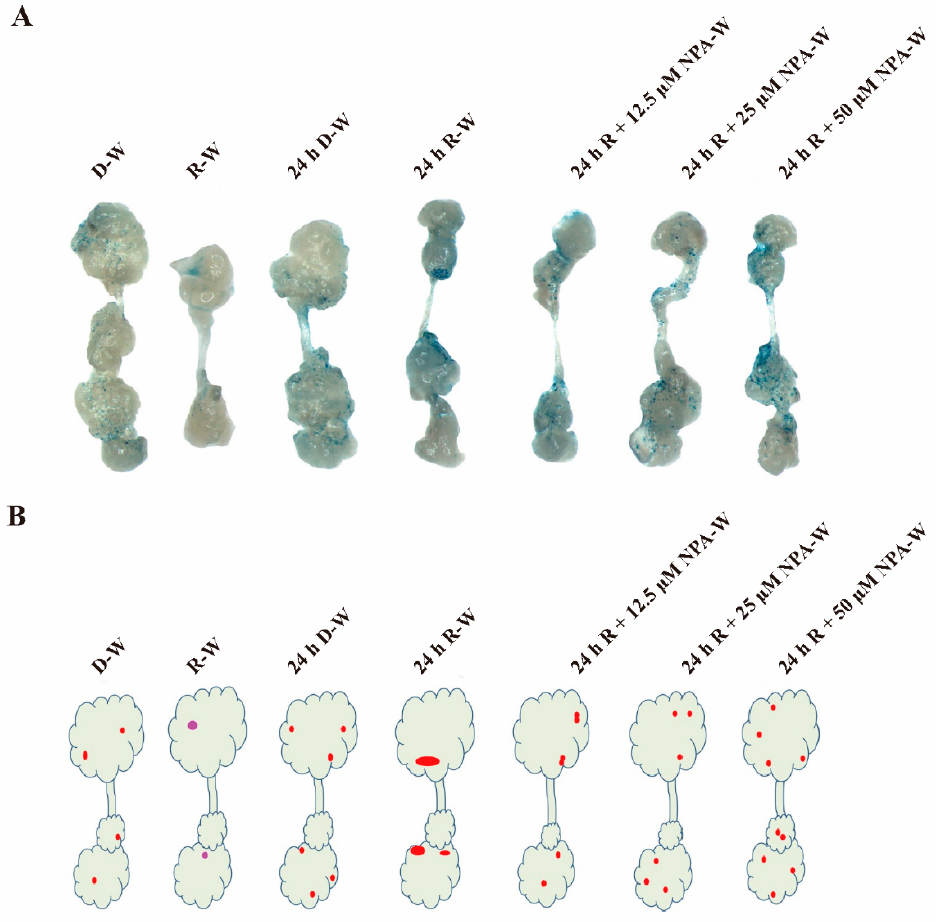
Figure 4. Dynamic localization and expression patterns of WUS under di ff erent light regimens and concentrations of NPA. ( A ) WUS localization patterns at day 7 on the SIM after di ff erent treatments. In contrast with D-W, the R-W treatment weakened the WUS signal, the 24 h R-W treatment promoted the centralized localization in the middle of the explant, the 24 R-NPA-W treatment increased the WUS signal and promoted a wider distribution of WUS . ( B ) A model for the WUS distribution pattern under di ff erent treatments. Red spots indicate strong WUS signal, pink spots indicate weak WUS signal. The size of spots indicates the area of WUS signal. Three biological replicates were performed for each experiment, and each replicate contained 120 root segments. Calluses derived from root segment were stained.